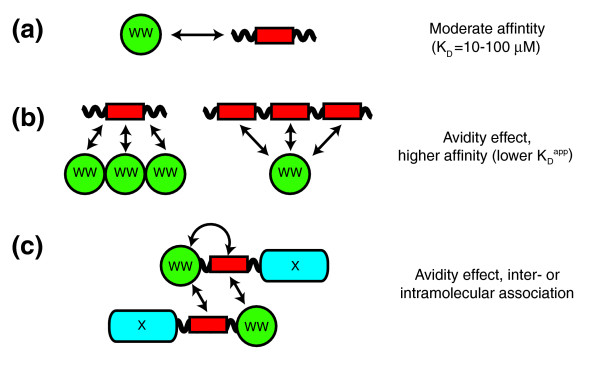
A model for the optimization of interactions between WW domains and protein ligands. WW domains are colored green, WW ligand binding motifs are colored red, and auxiliary protein domains are in blue.